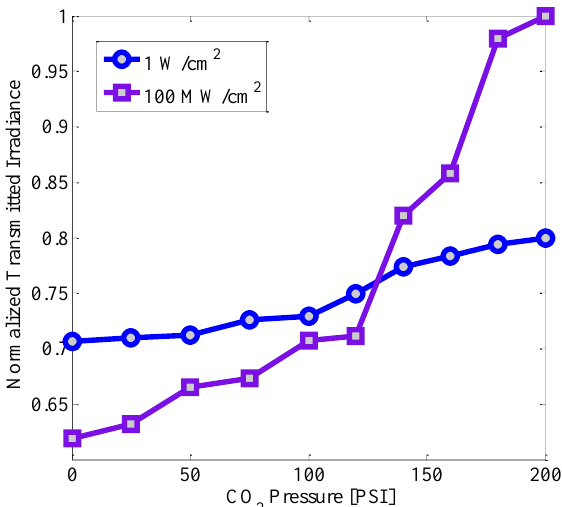
Figure 6. Experimental results illustrating a change in the transmitted irradiance when the sample interacts with CO 2 at variable pressure and light waves with different intensities.